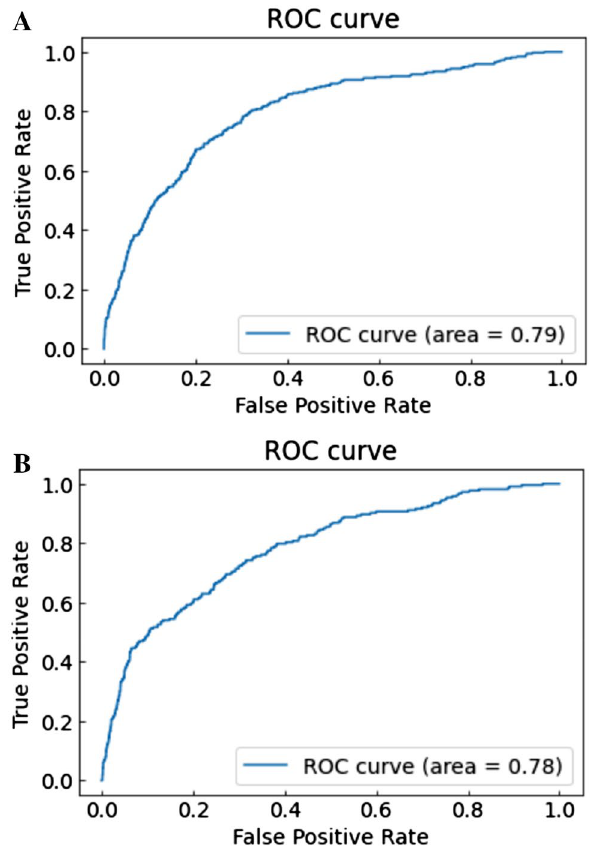
Figure 3. ( A , B ) ROC curve with training datasets using the light GBM with age, eGFR, preprocedural hemoglobin, ST-elevation myocardial infarction, non-ST elevation myocardial infarction/unstable angina, heart failure symptoms at admission and intra-aortic balloon pump. Abbreviations: GFR, glomerular filtration rate; GBM, gradient boosting model; ROC, receiver operating